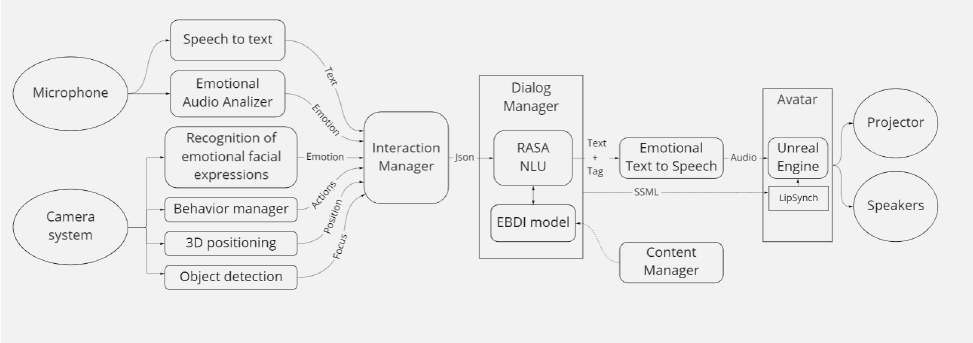
Figure 7. Proposed Framework for implementing an interactive on-site